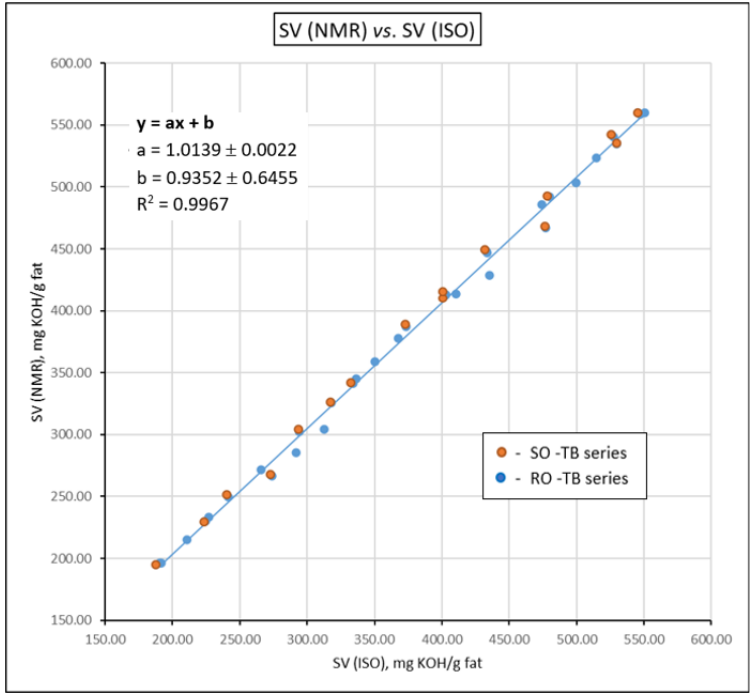
Figure 3. SV (NMR) plotted against the SV (ISO 3657:2013). Values for slope a and intercept b reported as the mean ± sd. The NMR experiments were performed in triplicate; ISO determinations were performed in duplicate.